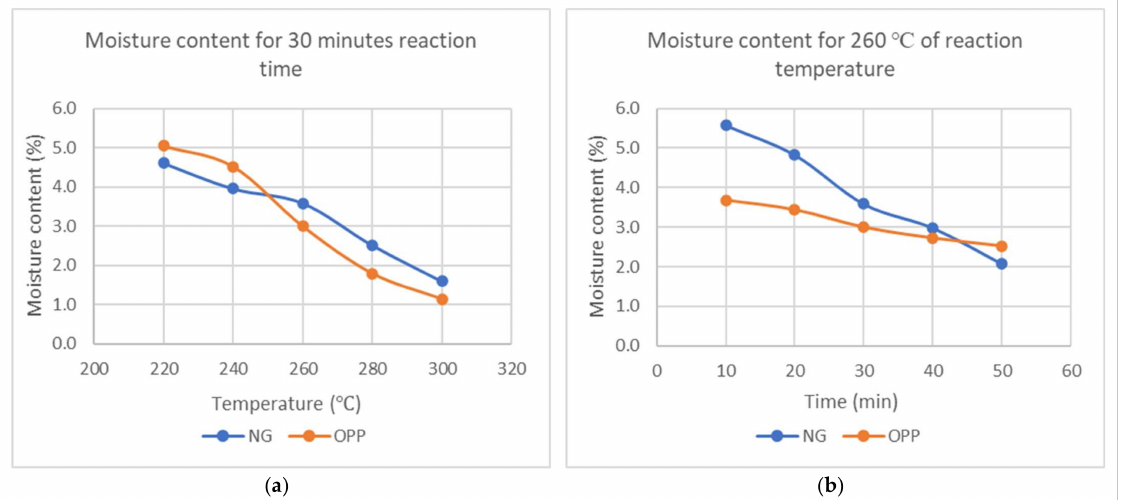
Figure 4. Moisture content ( a ) against temperature at constant reaction time of 30 min and ( b ) against reaction time at constant temperature of 260 ◦